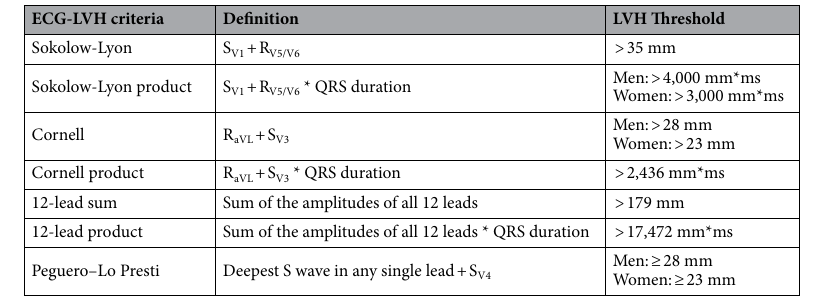
Table 1. Definitions of established ECG-LVH criteria. mm millimeter, ms